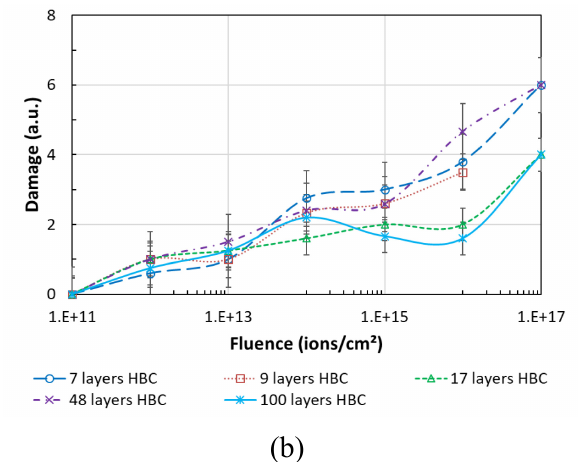
Fig. 4. Comparison of the damage grade with respect to fluence of two specific sets of samples (a) DLC, HBC and B/C mixture (b) HBC foils of different number of layers.